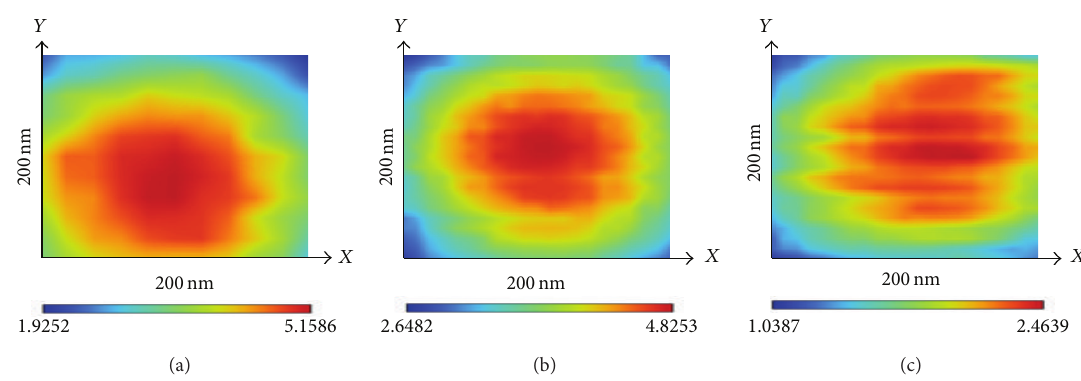
Figure 4: Tomographic images of a nanoparticle ( 𝑧 = 100 nm), measured with polarization interferometric nonlinear confocal microscope: (a) linear region ( 𝐼 = 8.0 W/cm 2 ), (b) nonlinear moderate intensity region ( 𝐼 = 1.0 × 10 2 W/cm 2 ), and (c) nonlinear high intensity region ( 𝐼 = 2.5 × 10 3 W/cm 2 ).